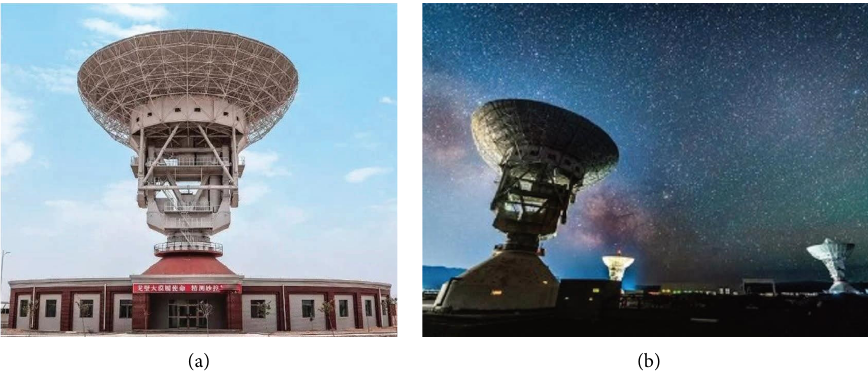
Figure 2: Kashgar deep space station (https://www.sohu.com/a/273044755_772793 https://www.163.com/dy/article/FI7MU2RQ0512B07B. html).